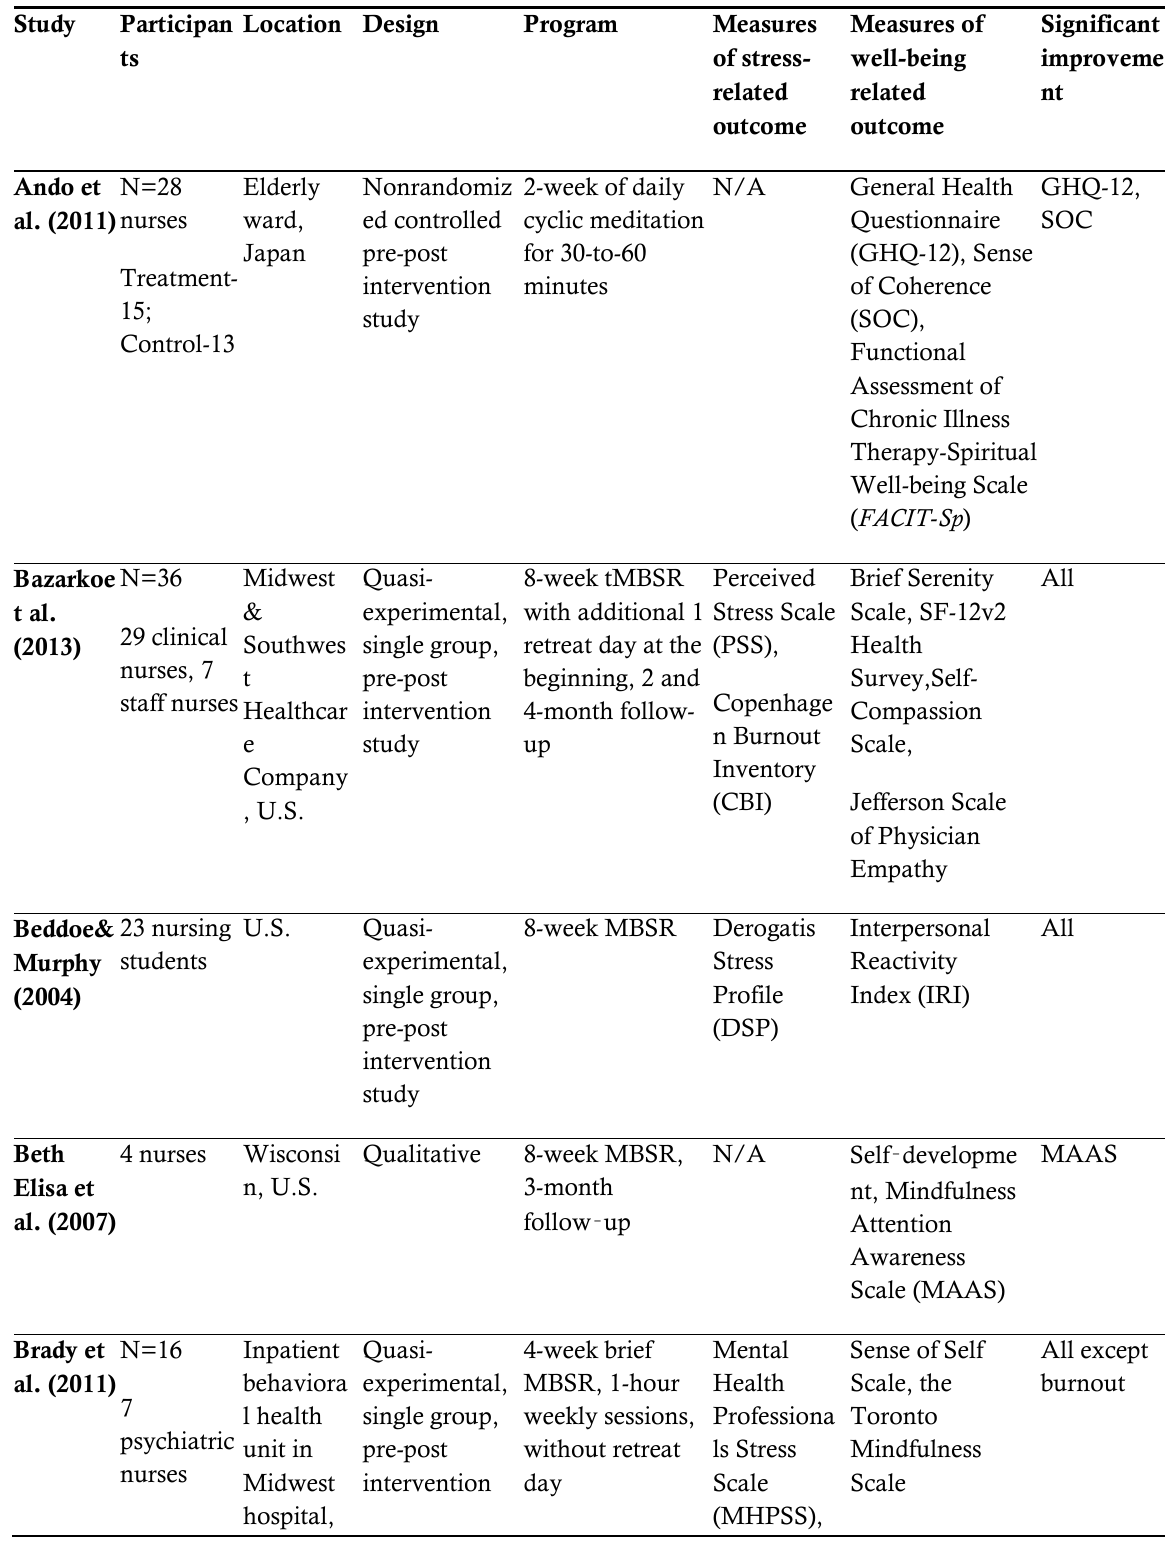
Table 1: Studies of mindfulness training programs on nursing stress Study Participan Location Design ts